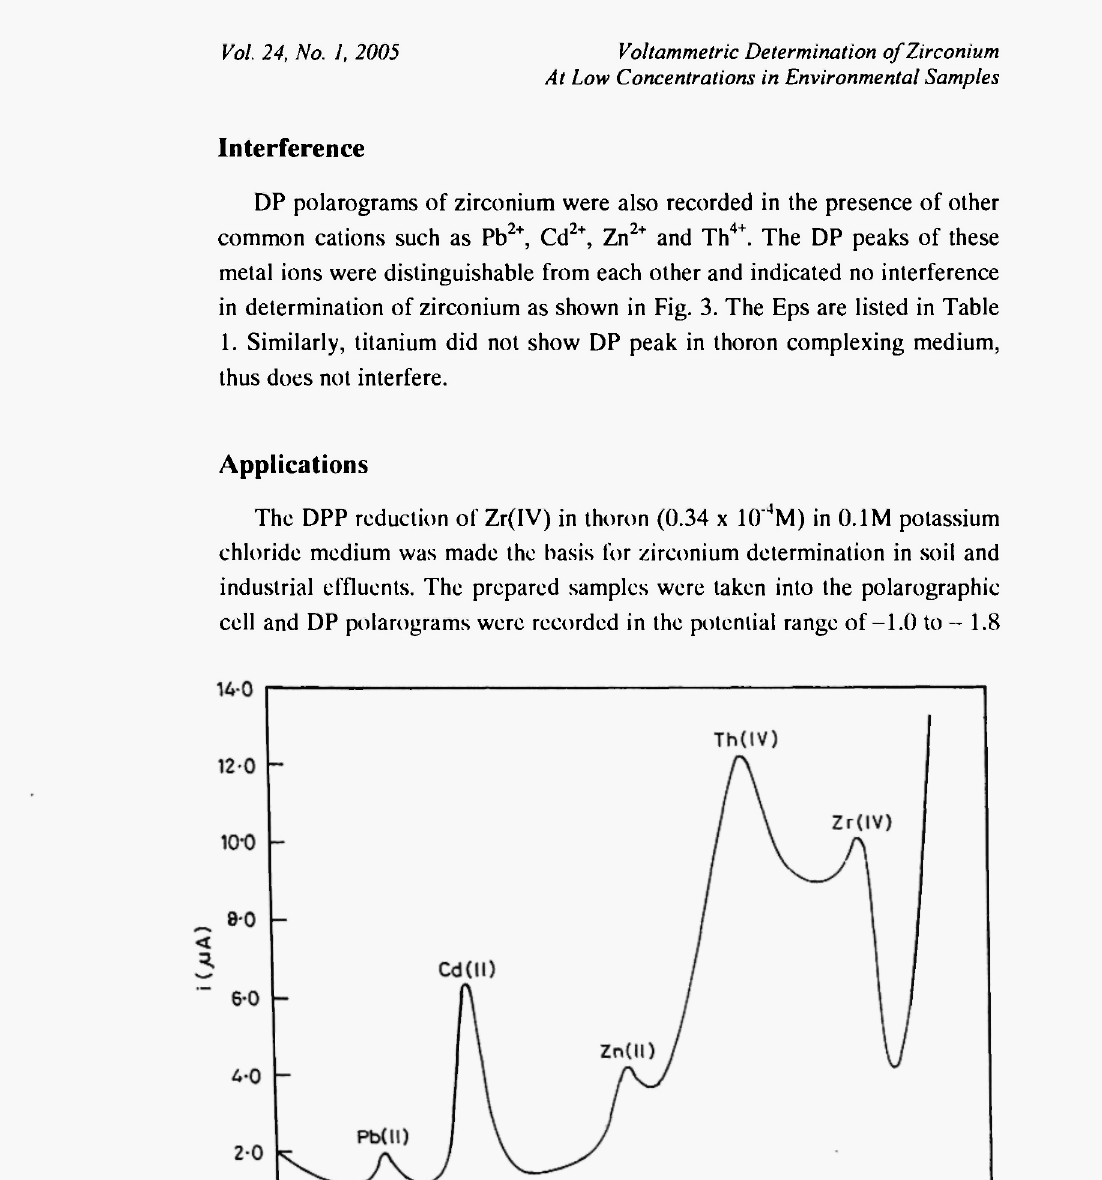
Fig. 3: DPP of a solution containing Pb (Il), Cd (Il), Zn(II), Th(IV) and Zr(IV) in 0.34 χ 10" 4 M thoron + 0.1 Μ KCl. Modulation amplitude = 50 mV; pulse duration = 57 ms, Clock time of pulse = 1 s and scan rate = 5 m